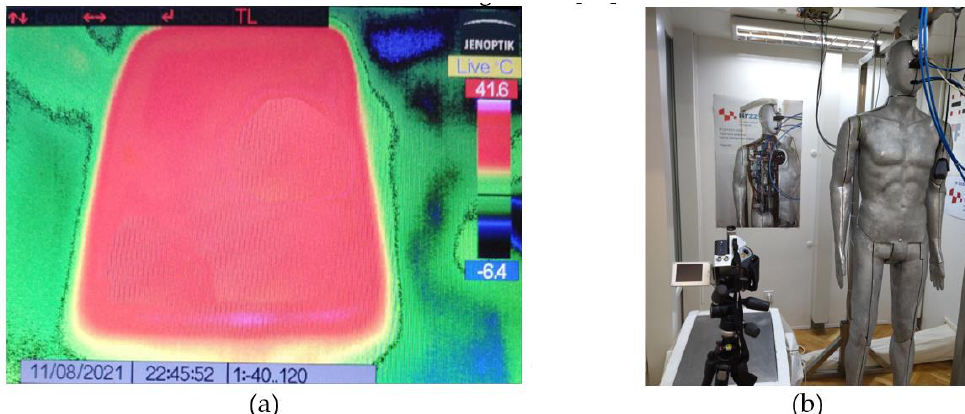
Figure 4. Examination of non-uniform temperature distribution in the casting surface using an IR camera: ( a ) the uniform temperature distribution in the casting surface measured using an IR camera; ( b ) the recording mode in the thermal chamber where the measurement plate and the thermal mannequin are located.